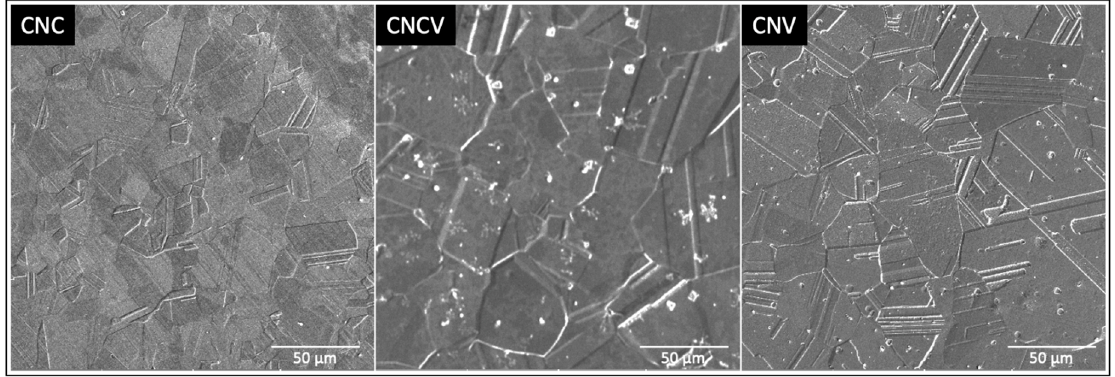
Figure 3. The SEM images of the microstructures of the CNC, CNCV, and CNV alloys.